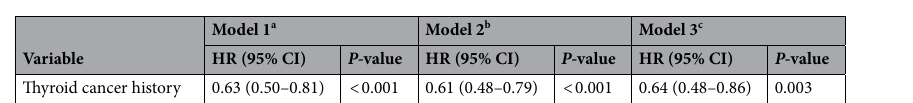
Table 3. The effect of thyroid cancer history on the risk of PLC-specific death among PLC patients. PLC primary liver cancer, HR hazard ratio, CI confidence interval. a Model 1 was established as a crude model without adjustment. b Model 2 adjusted for age and gender. c Model 3 adjusted for age, gender, race, marital status, tumor size, regional nodes positive, primary site, histology groupings, surgery, chemotherapy, histologic grade, AJCC T status, AJCC N status, AJCC M status, SEER historic stage.